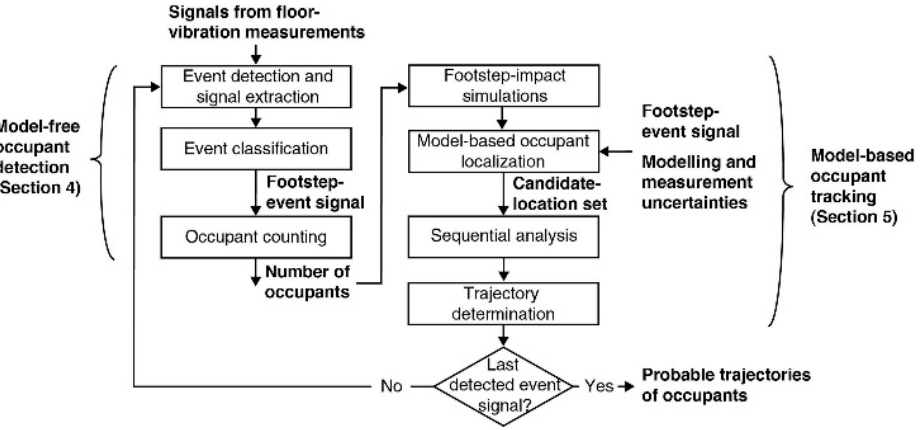
Figure 5. Occupant detection, localization, and tracking framework using footstep-induced floor vibrations [94]. vibrations